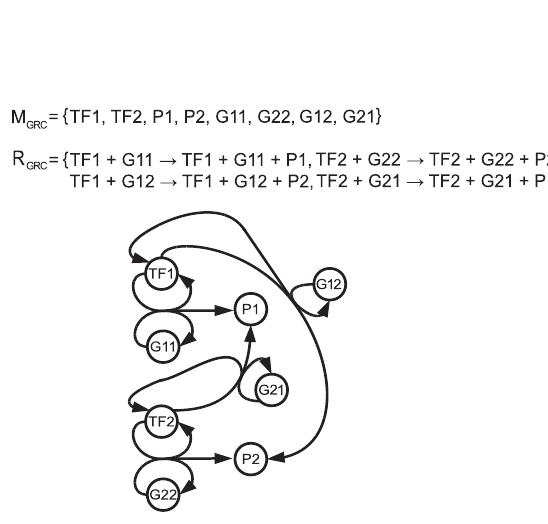
Figure 3. Gene regulatory network model. Panel A: Model of the expression of a gene, and the reaction network formulation of the same process (below). Blue text in panel A indicates the semantic interpretation, i.e. the transcription factors are the signs, the products are the meanings, and the DNA is the molecular context. Panel B: reaction network constructed according to the formalization of gene regulation shown in (A) containing two transcription factors (TF1, TF2), two gene products (P1, P2) and the according genes (G11, G12, G21, G22).